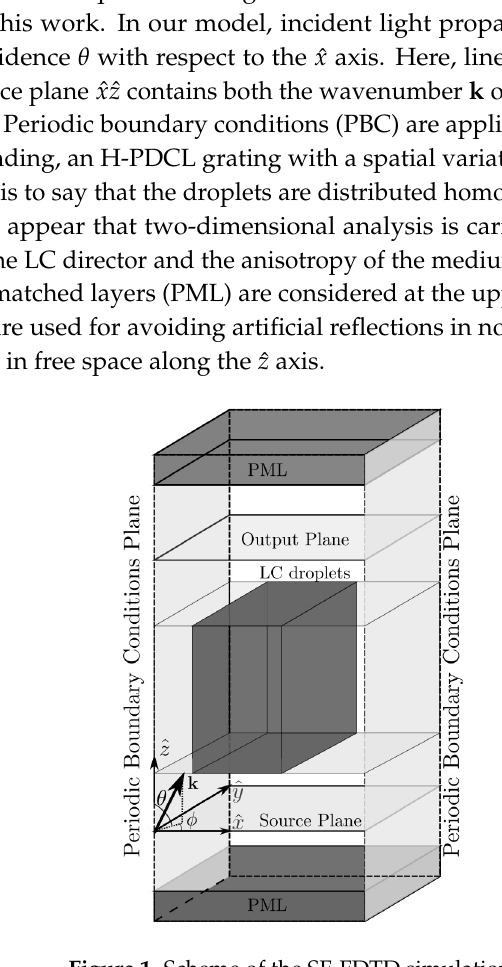
Figure 1. Scheme of the SF-FDTD